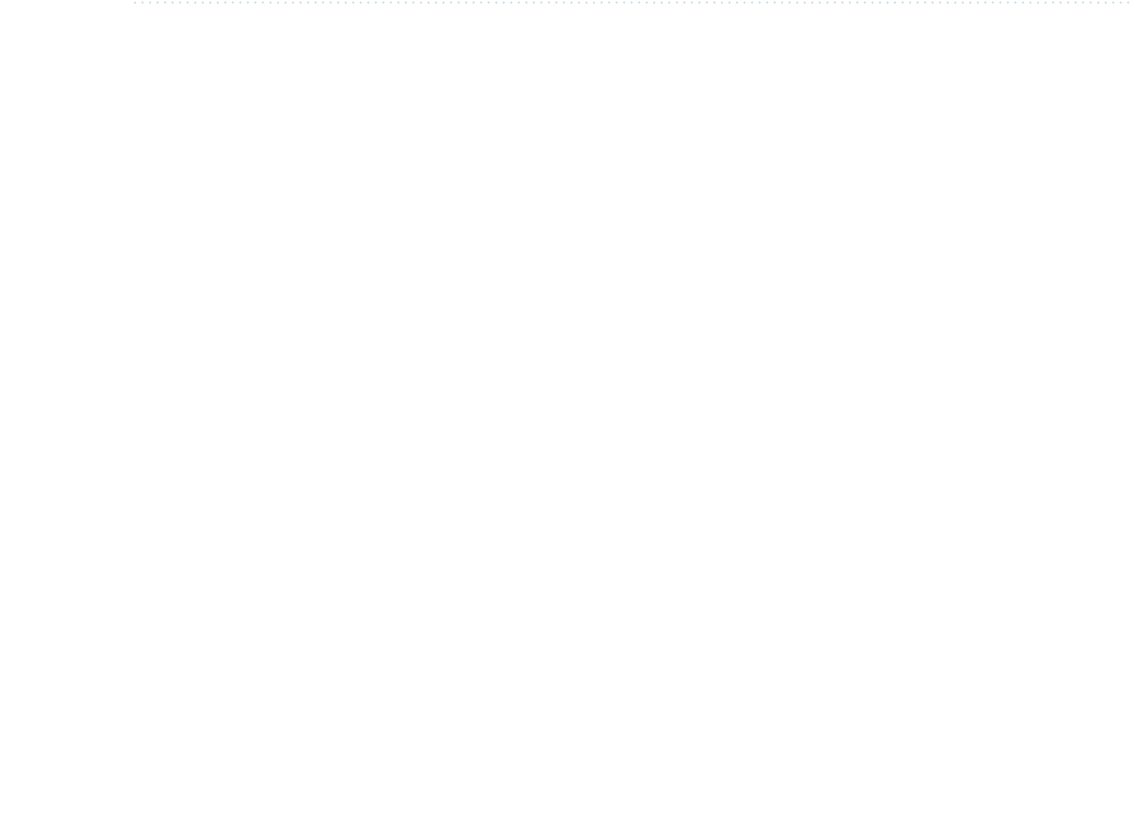
Figure 22. Example